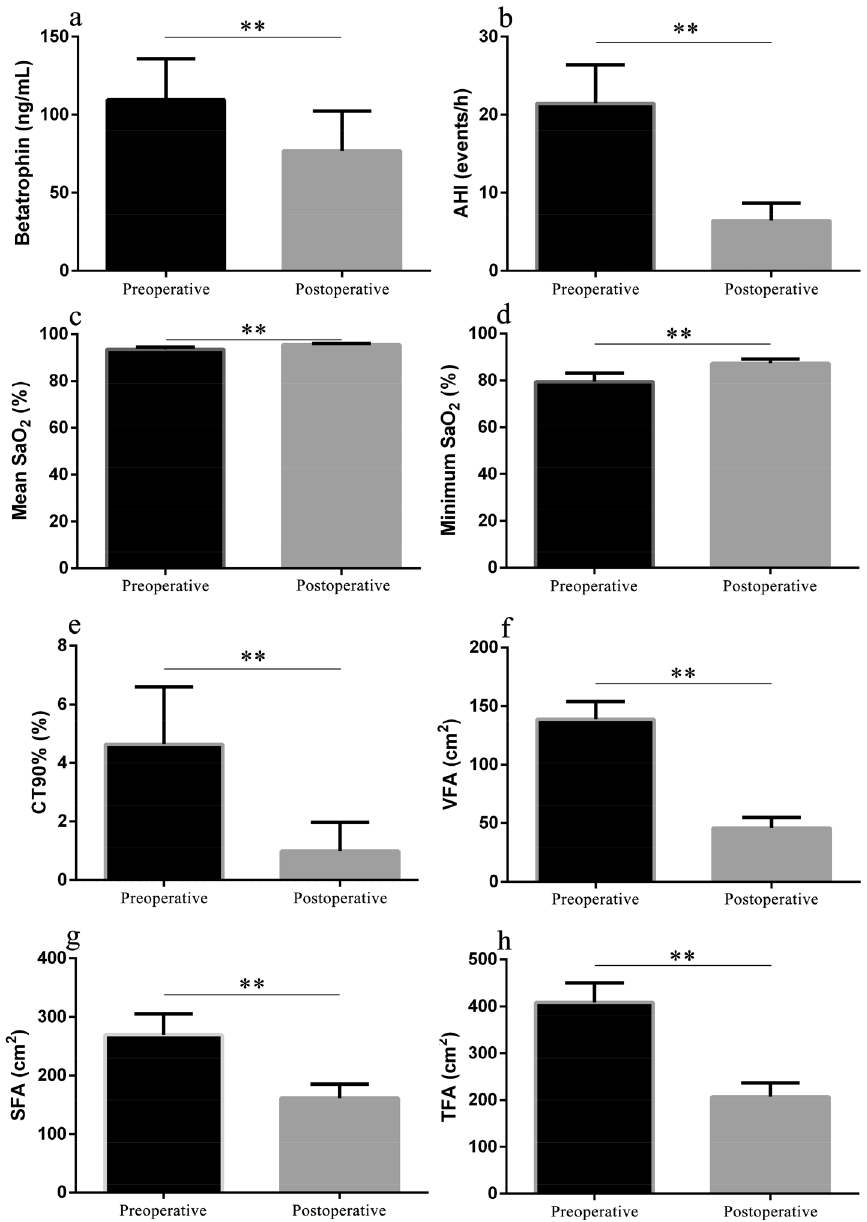
Figure 1. Comparisons of parameters of betatrophin ( a ), AHI ( b ), mean SaO 2 ( c ), minimum SaO 2 ( d ), CT90% ( e ), VFA ( f ), SFA ( g ) and TFA ( h ) between baseline and one year after RYGB. **p < 0.001. Data were shown as mean (95% confidence interval). RYGB Roux-en-Y gastric bypass, AHI apnea hypopnea index, SaO 2 oxygen saturation, CT90% percentage of time spent at SaO 2 < 90%, VFA visceral fat area, SFA subcutaneous fat area, TFA total fat